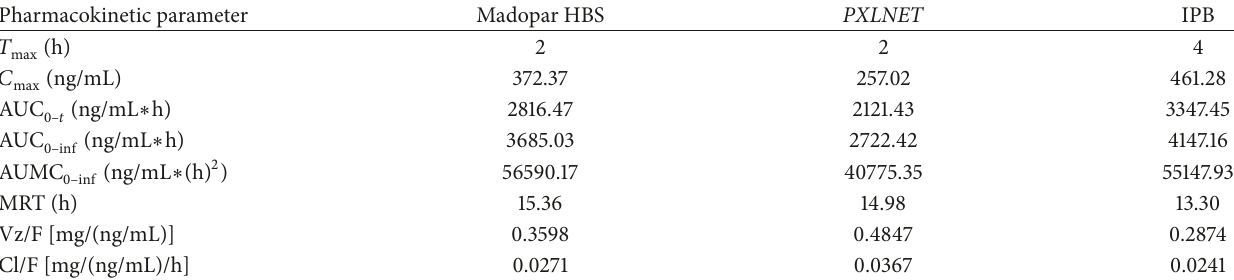
Table 8: Levodopa noncompartmental pharmacokinetic parameters following oral administration of Madopar HBS capsules, PXLNET , and IPB